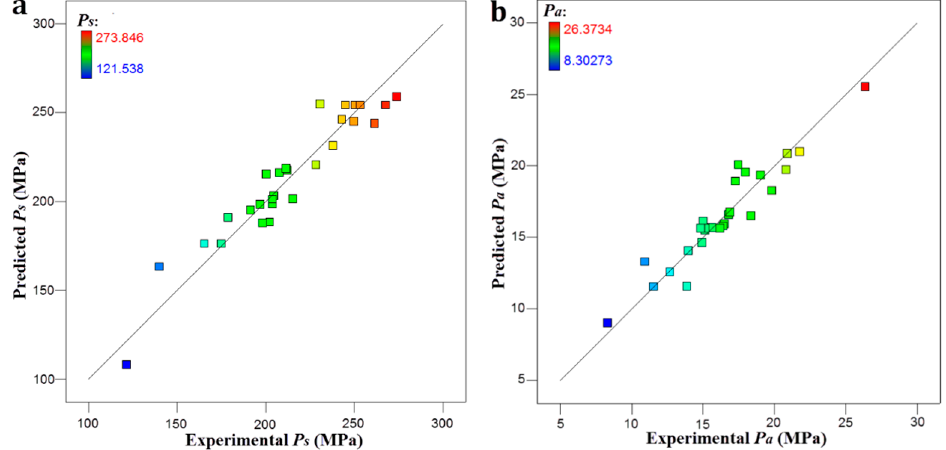
Figure 5. Experimental and predicted values of both responses. ( a ) lap shear strength P s ; ( b ) cross peeling strength P a .